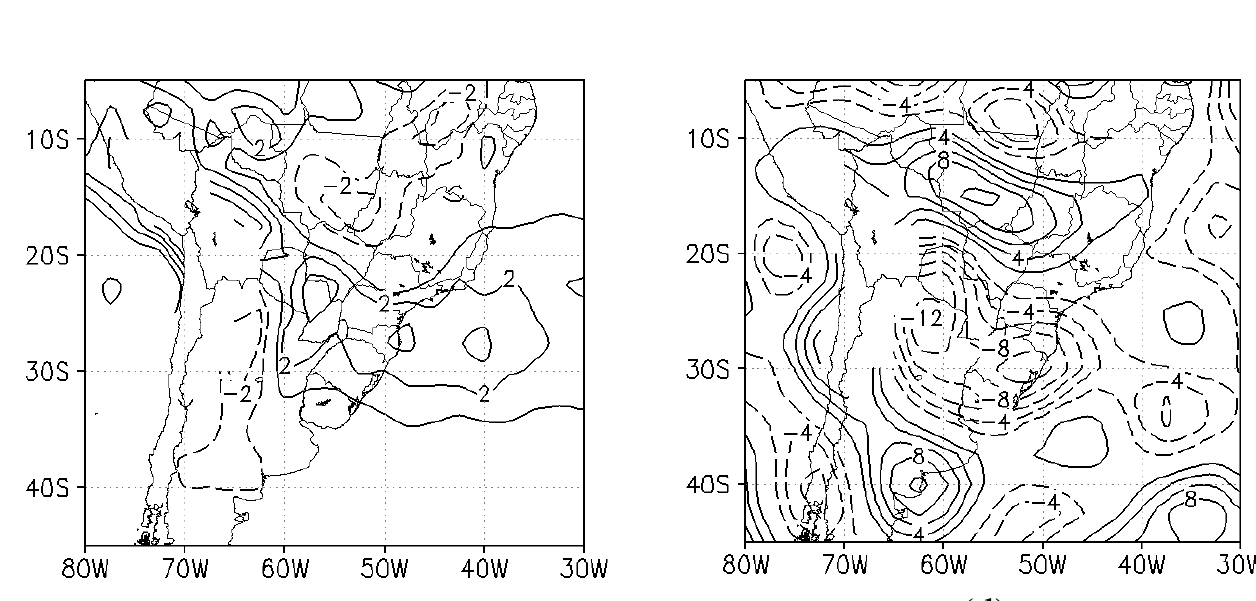
Fig. 13 – Same as in Fig. 5 except for Case 32 (02-11 Jun 2002). Fig. 13. Same as in Fig. 5 except for Case 32 (2–11 June 2002).